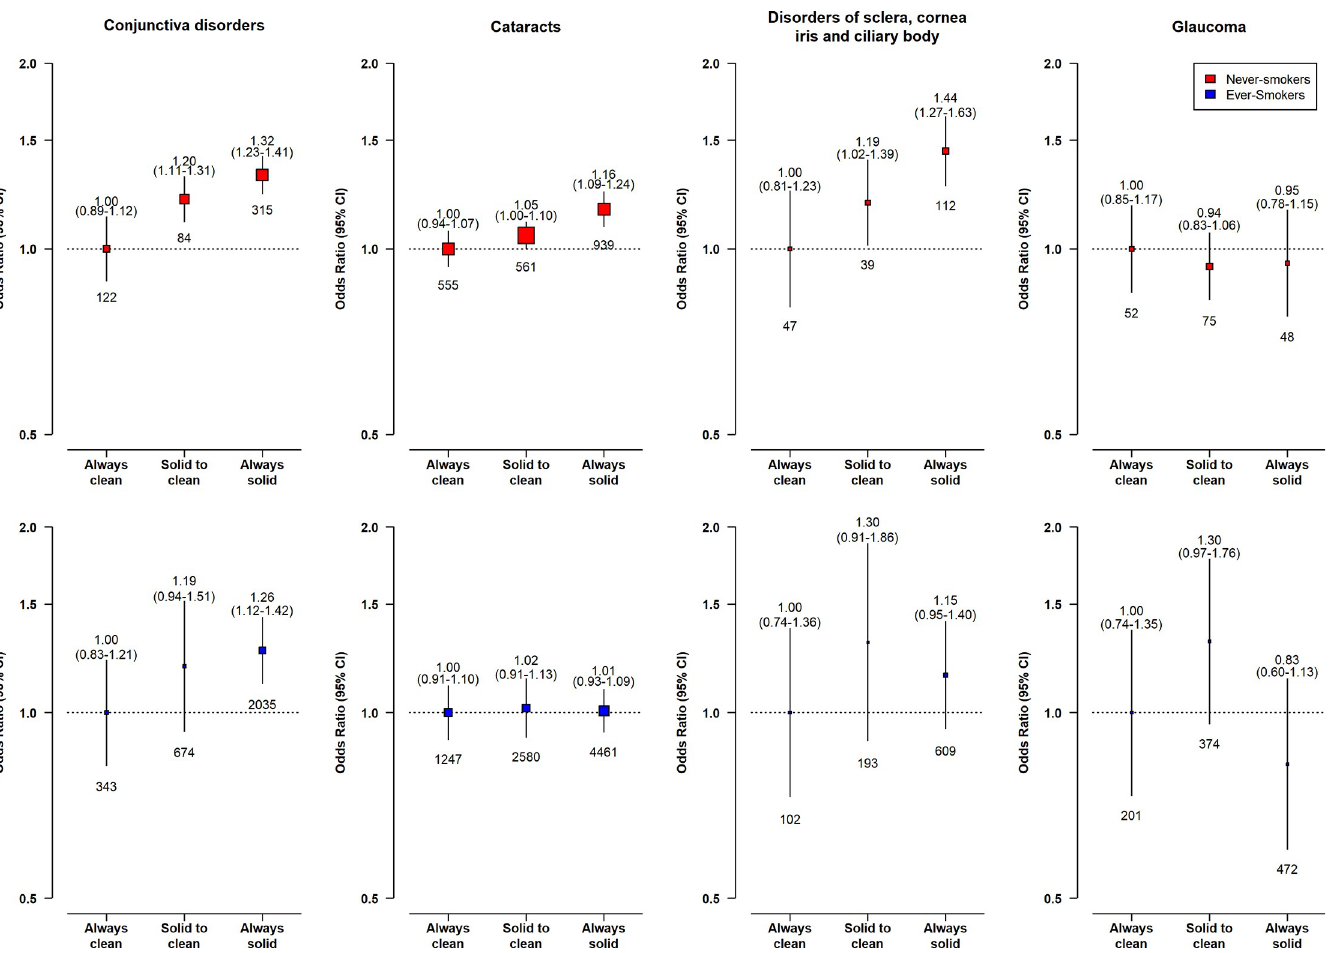
Fig 3. Associations of long-term cooking fuel exposure with major eye disease incidence in never- (red) and ever- (blue) regular smokers. ORs were adjusted for age at baseline, birth cohort, sex, study area, education, occupation, passive smoking, cookstove ventilation, heating fuel exposure, BMI, prevalent diabetes, self-reported general health, and length of recall period. The graphics are formatted as in Fig 1. BMI, body mass index; CI, confidence interval; OR, odds ratio.